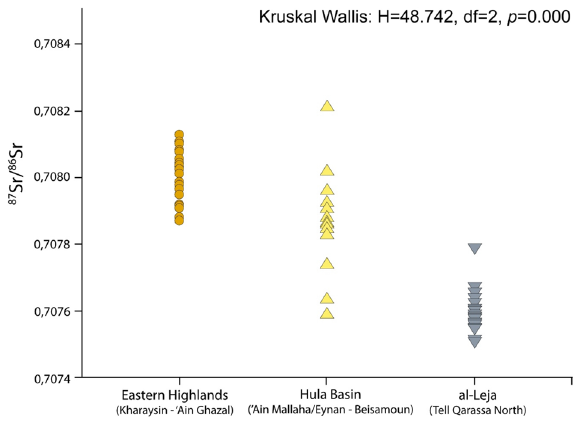
Figure 2. Scatter plot of the 87 Sr/ 86 Sr ratios according to the geological areas identified in the study. The Eastern Highlands includes 87 Sr/ 86 Sr ratios of human samples from the sites of Kharaysin and ‘Ain Ghazal (Cretaceous limestone). The Hula Basin in the upper Jordan Rift Valley corresponds to the sites of Ain Mallaha/Eynan and Beisamoun (Hula Basin: basalt soil, terra rossa and Cretaceous limestone) Those from Al-Leja are from the site of Tell Qarassa North (Late Miocene, Pliocene, and Quaternary